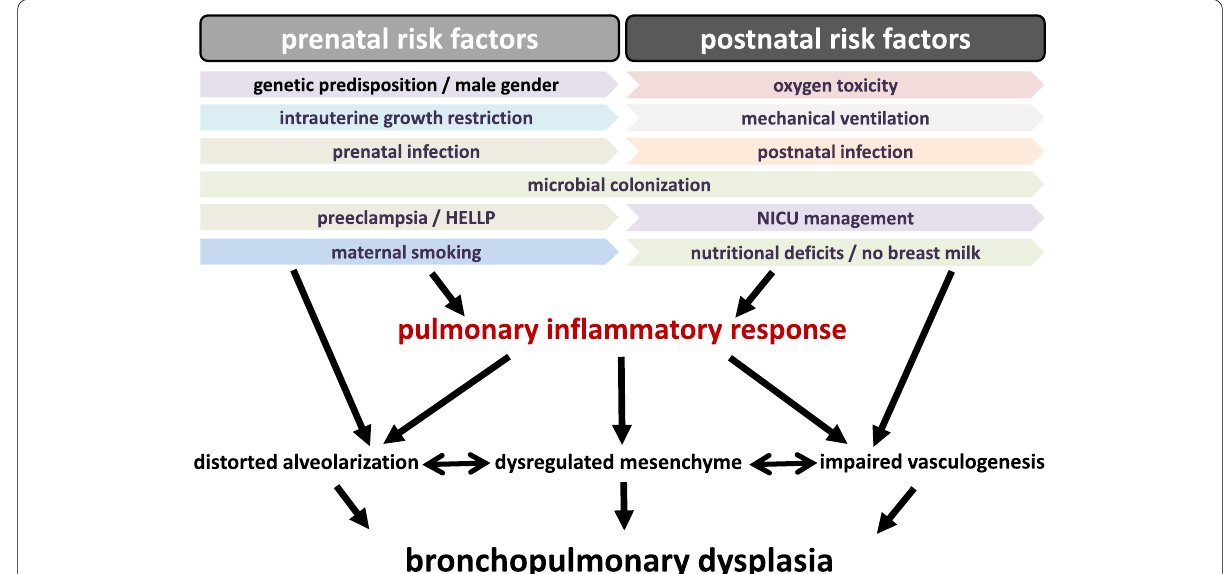
Fig. 1 Central pre‑ and postnatal risk factors for BPD development. The key contributors to the development of BPD are split into prenatal and postnatal risk factors (scheme developed from our previous review on the topic